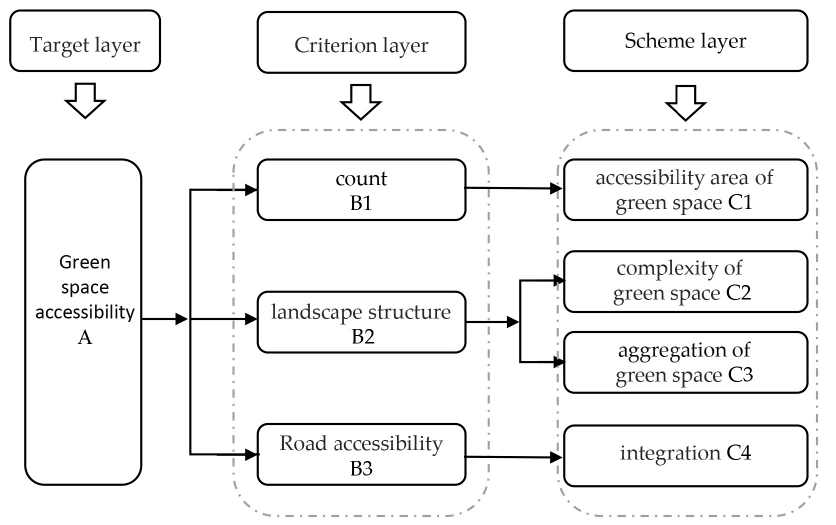
Figure 11. Green space accessibility model hierarchy. Table 7. Weight value of factors.